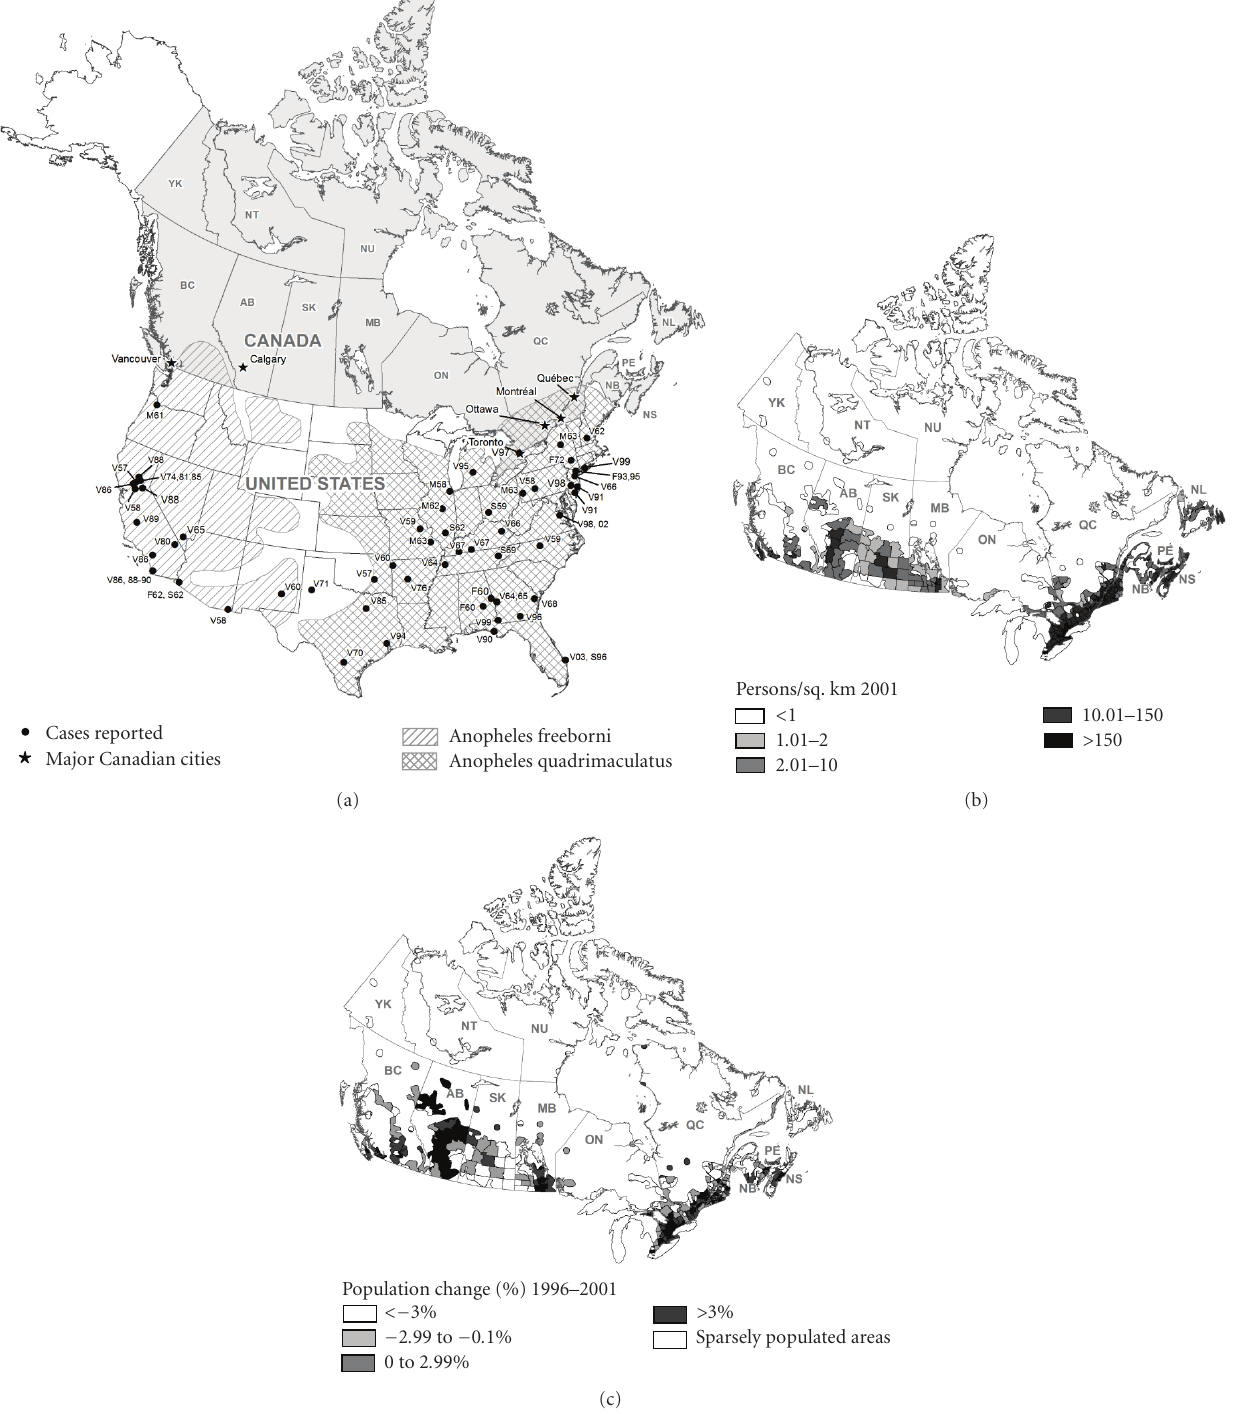
Figure 2: Geographic distribution of vectors of malaria, cases of local mosquito-borne transmission during the period 1957–2003 Figure 2(a), population density Figure 2(b), and population change Figure 2(c) in Canada. (a) shows the geographic distribution of vectors of malaria and cases of local mosquito-borne transmission during the period 1957–2003. Black dots represent location of cases of malaria in the United States and Canada presumed to be acquired from local mosquito-borne transmission between 1957 and 2003 (Source: [1, 38–45]. Each dot represents one or a cluster of cases in a given year. Labels include species type (V = P. vivax, F = P. falciparum , M = P. malariae , S = species unknown) and date. Locations are approximate. Hashed areas represent the approximate distributions of the two most important competent malaria vectors in Canada. (Sources of malaria data: [1, 30–34]). See Table 2 for full names of Canadian provinces. (b) and (c): population density (2001) and population change (1996–2001) in Canada. Source: Population Ecumene Census 2001, GeoGratis, Natural Resources